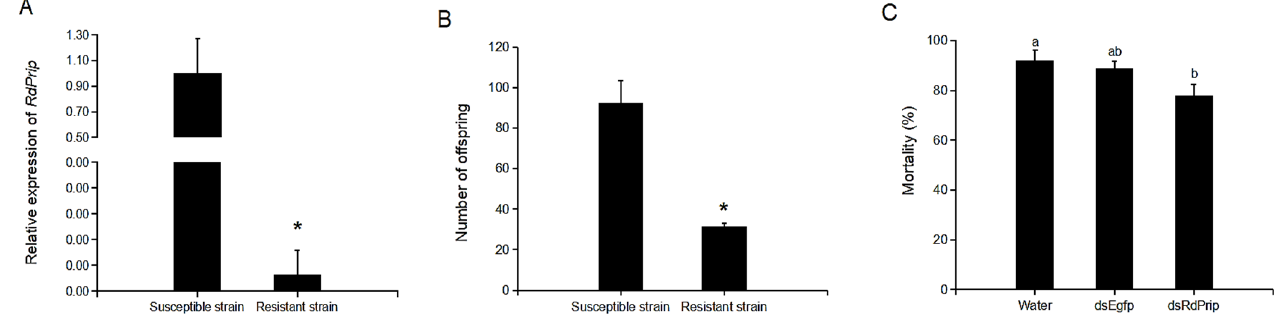
Figure 4. Association of RdPrip functions with spinosad in R. dominica . ( A ) qPCR analysis of RdPrip in susceptible and resistant strains. ( B ) The number of offspring was higher in susceptible strains than in resistant strains. ( C ) The mortality of R. dominica to spinosad exposure after knockdown of RdPrip . The error bar represents the standard error of replicates. * or different letters indicate significant differences between treatments ( p < 0.05).